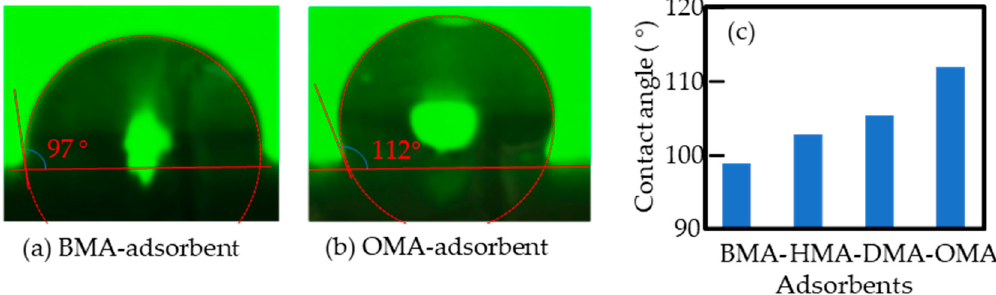
Figure 3. Water droplets on the BMA-adsorbent ( a ) and OMA-adsorbent ( b ). Contact angle of the water droplets on the four fabric adsorbents ( c ).